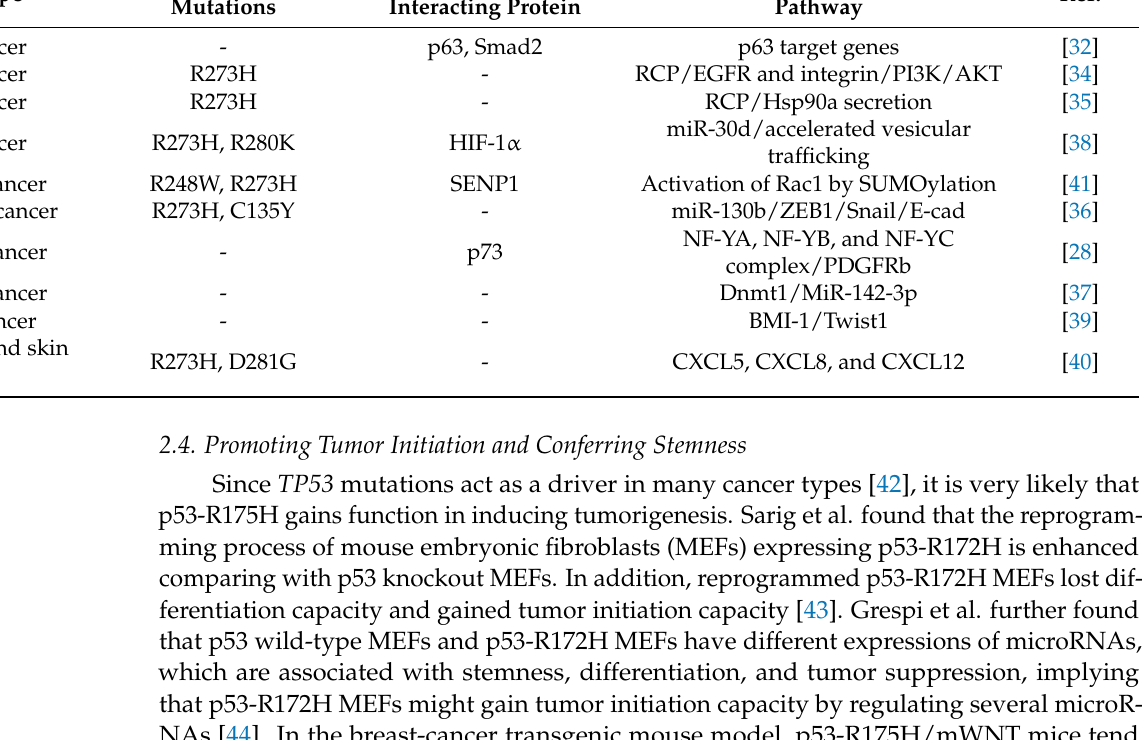
Table 4. Summary of p53-R175H gain-of-function of promoting tumor migration, invasion, and metastasis. Tumor